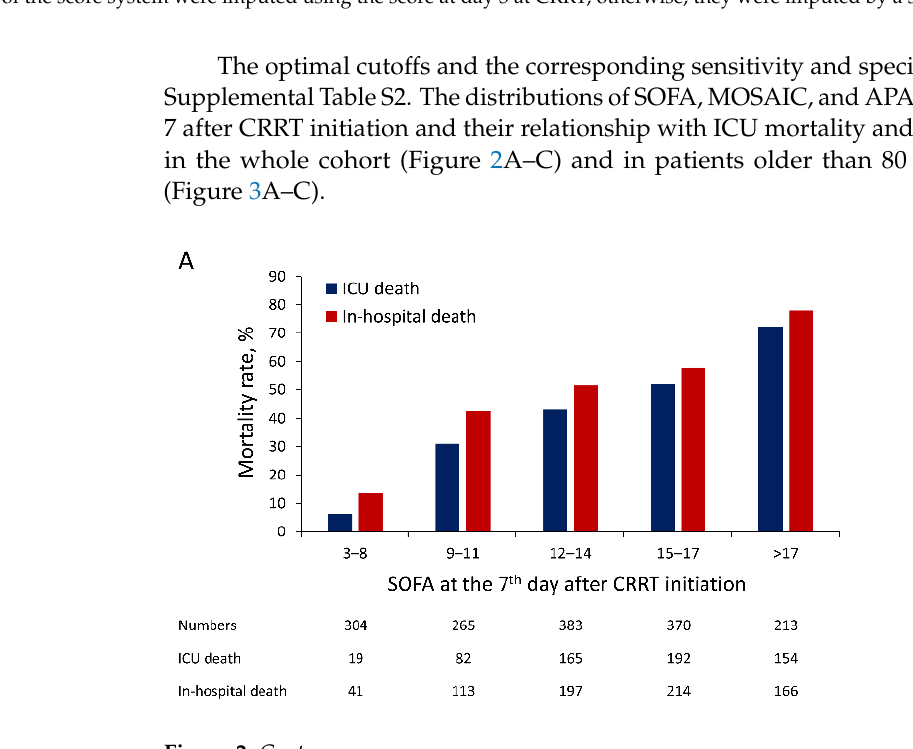
Figure 2. Distribution of SOFA ( A ), MOSAIC ( B ), and APACHE III ( C ) scores at day 7 after CRRT initiation and their relationship with ICU mortality and in-hospital mortality in the whole popula- tion. SOFA, Sequential Organ Failure Assessment; APACHE, Acute Physiology and Chronic Health Evaluation; MOSAIC, Mortality Scoring system for AKI with CRRT.